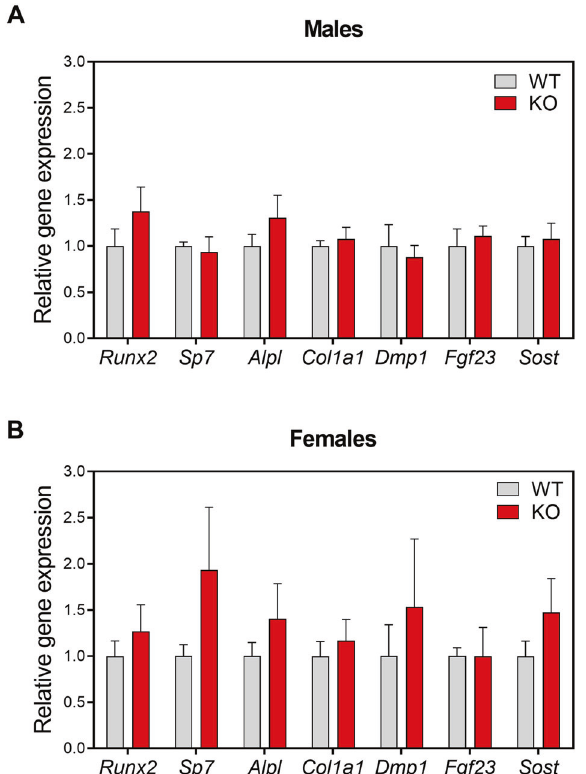
Fig. 4 Expression levels of osteoblastic genes in Herc1 knockout mice. A , B We analyzed mRNA isolated from the femurs of 8-week- old WT or Herc1 -KO mice by RT-qPCR, normalized to Gapdh expression ( n = 4 – 9) and expressed as mean ± SEM. KO knockout, WT